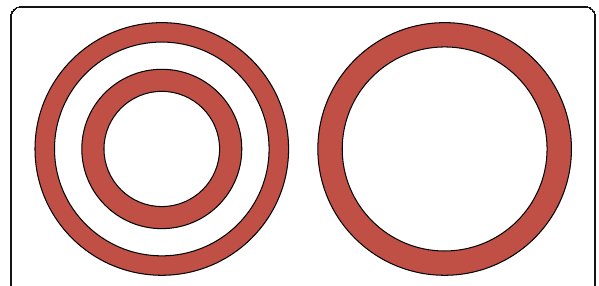
Fig. 8 Structure diagram of asymmetrical coupling coil. a Transmitting coil. b Receiving coil